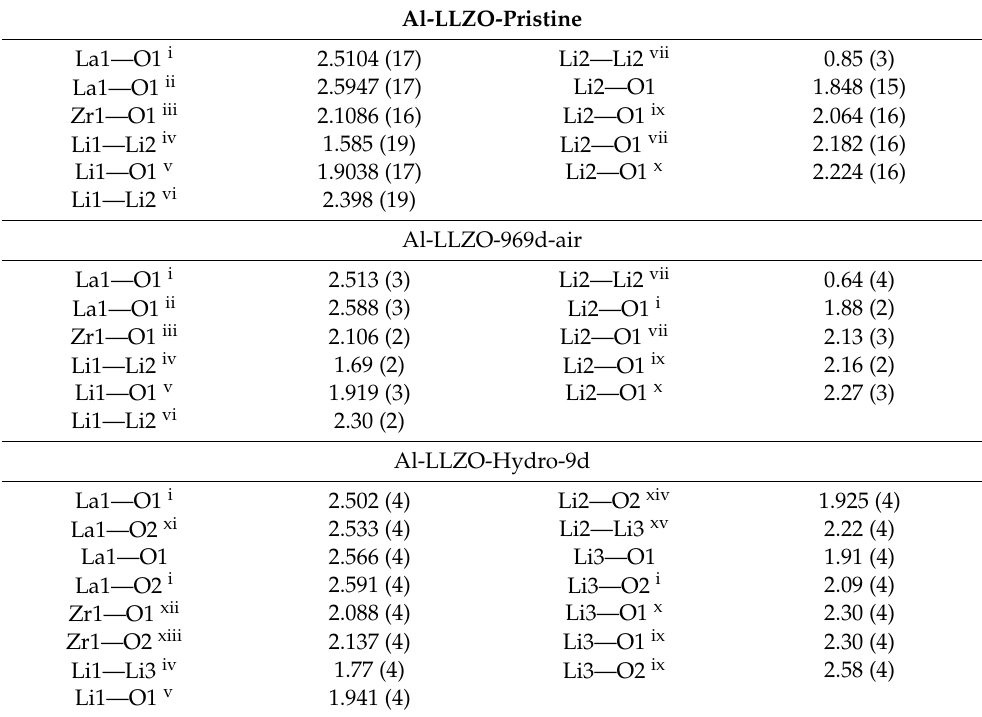
Table 4. Selected bond lengths for the Al- and Ga-stabilized LLZO samples are listed in Table